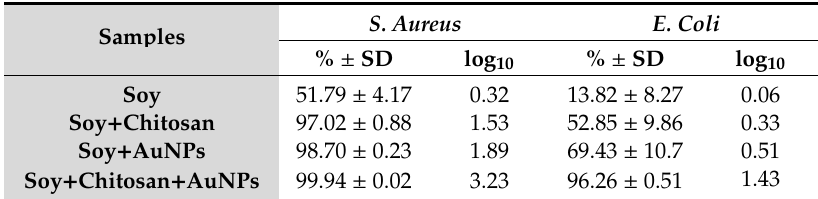
Table 6. Fabrics’ antimicrobial e ffi cacy against S. aureus and E. coli assessed quantitatively following the standard shake flask method (ASTM-E2149-01) for a 24 h incubation period. Results are present in the form of mean % bacterial reduction ± SD and log 10 .